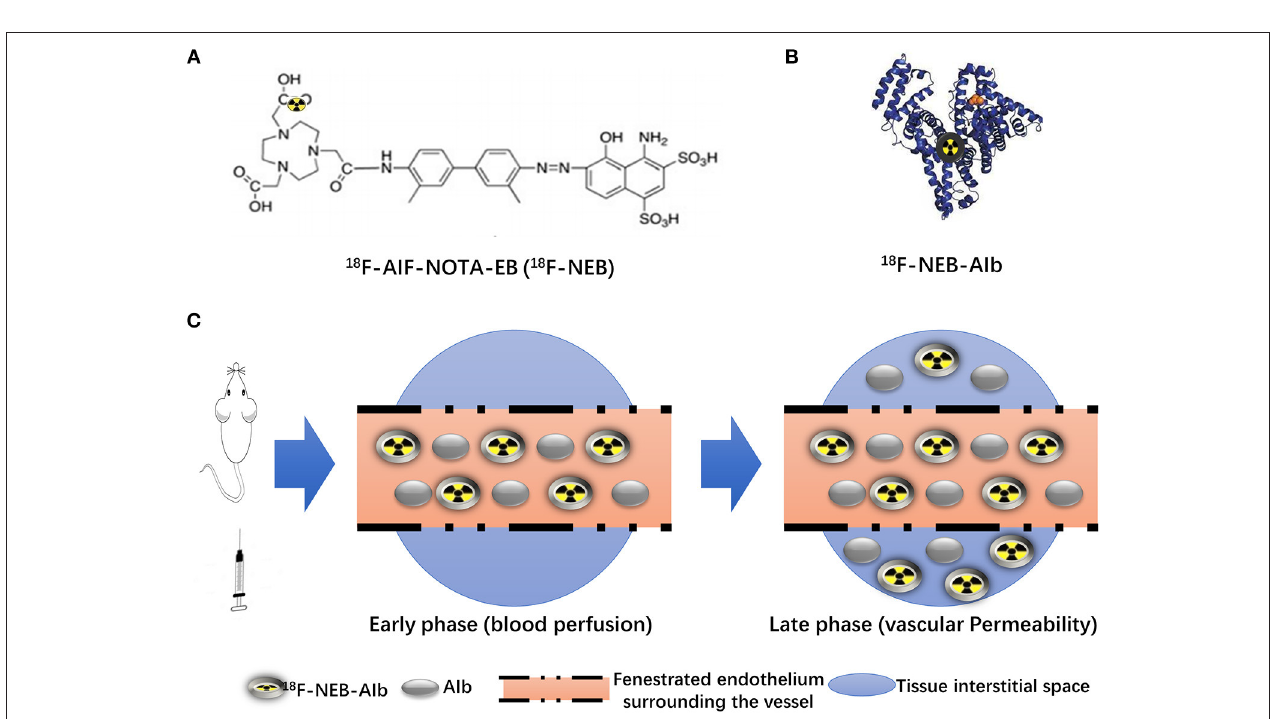
FIGURE 2 | Principle of 18 F-NEB application in HI model. (A) Chemical structure of NOTA conjugated truncated Evan’s Blue (NEB) and radiolabeling of NEB with 18 F-aluminum ( 18 F-AIF-NOTA-EB/ 18 F-NEB). (B) The binding of 18 F-AIF-NOTA-EB with serum albumin, forming the macromolecule 18 F-AIF-NOTA-EB-AIb ( 18 F-NEB-AIb). (C) Schematic diagram of 18 F-NEB imaging. After i.v injection of 18 F-NEB into surgical mice, sectional serum albumin was labeled with the probe immediately. In the early phase, circulation of 18 F-NEB-AIbwithin the vessel lumen enables the blooding pool imaging as well as the blood flow perfusion imaging in the hindlimb region. Then the 18 F-NEB-AIb gradually extravagated through the fenestrated endothelial junctions into to interstitial space, allowing for vascular permeability evaluation in the late phase.